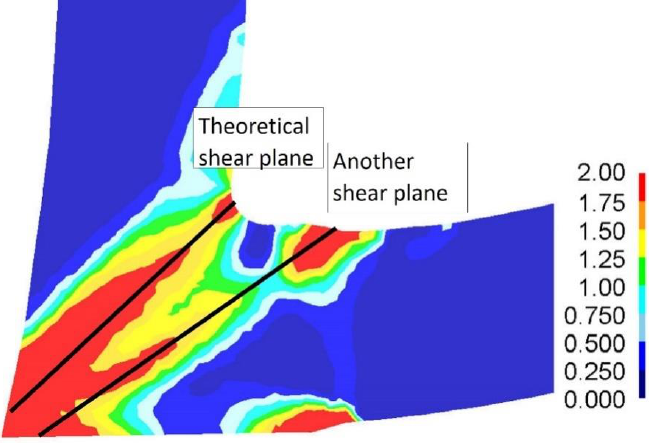
Figure 11. Simulated strain rate, as in reference [39].